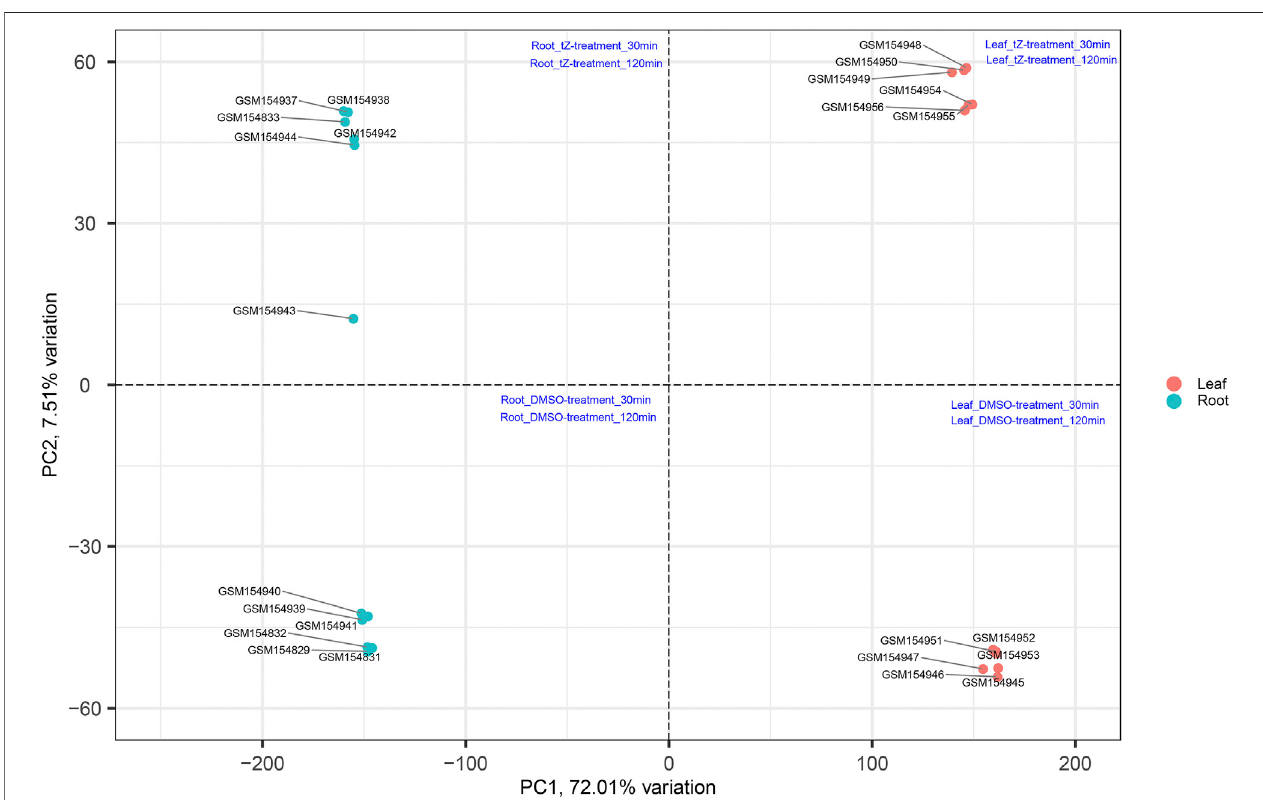
FIGURE 10 | Distribution of samples based on different stress at different timeintervals and obtained uniform distribution of data in all four coordinates (Szklarczyk et al., 2017).